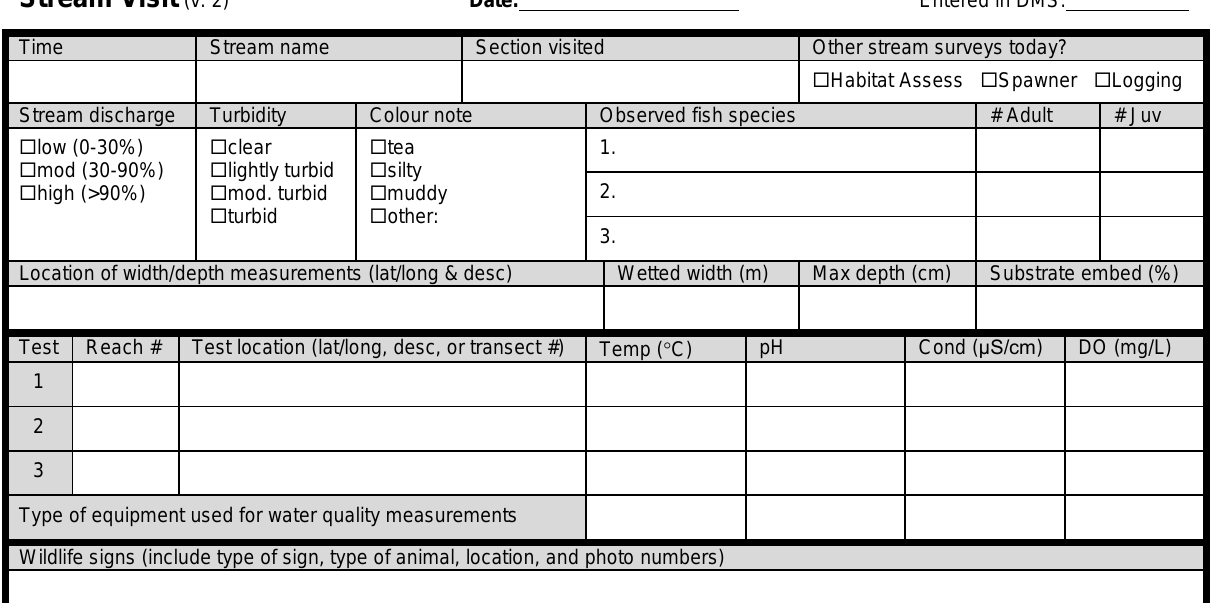
Fig. A1.4 – The Stream Visit card, which is to be used along with the Stream Assessment card and Stream Transect card, or individually if time does not permit a full